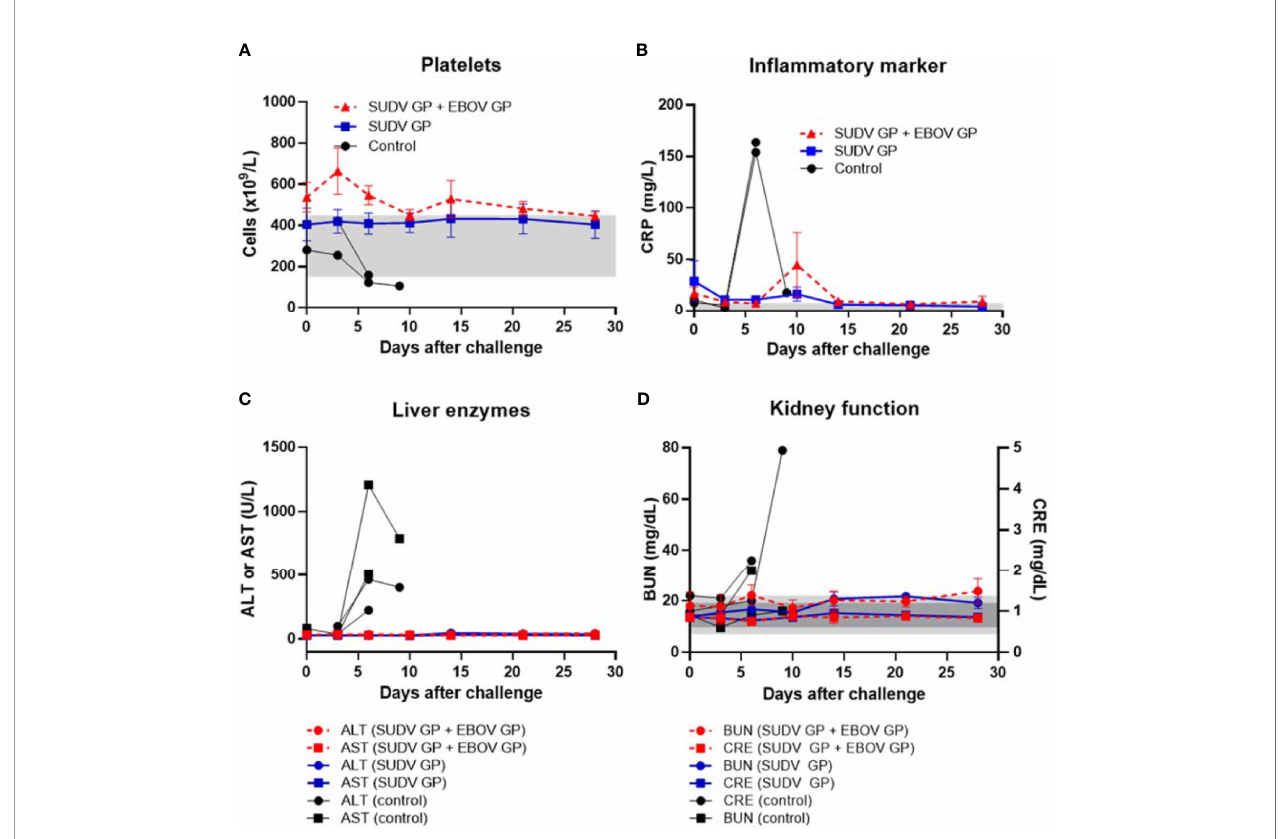
FIGURE 5 | Platelet counts, in fl ammatory marker, liver enzymes, and kidney function after SUDV challenge. (A) Platelet counts with normal range of 150-450 x 10 3 cells/ m L shown as light grey band. (B) Serum CRP with normal range of 0.0-7.5 mg/L shown as light grey band. (C) Serum ALT with normal range of 10-47 U/L and serum AST with normal range of 11-38 U/L. (D) Serum BUN with normal range of 7-22 mg/dL shown as light grey band and CRE with normal range of 0.6-1.2 mg/ dL shown as darker grey band. Each data point for vaccinated groups represents mean ± SEM. Data points for controls were plotted per individual